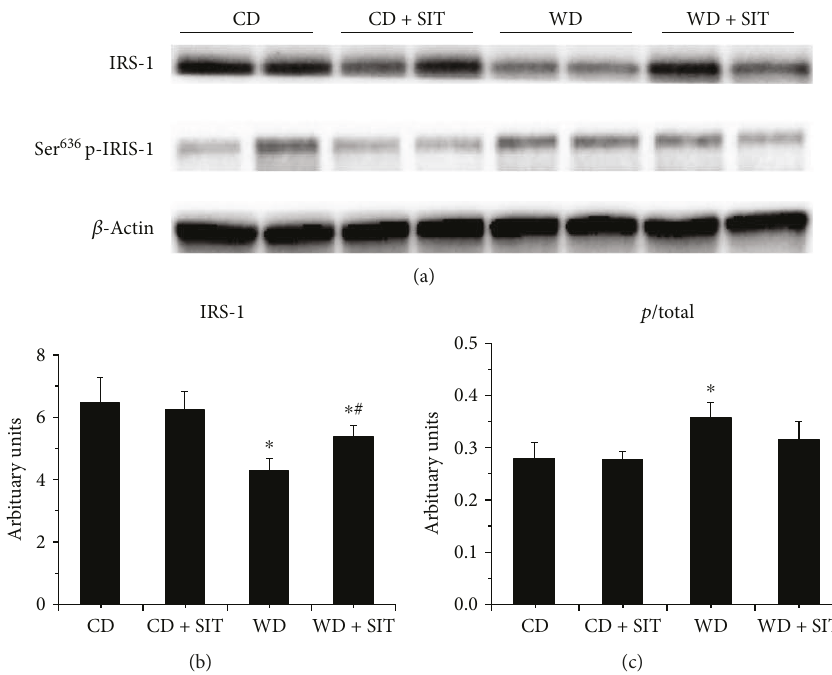
Figure 4: Western blot analysis of phosphorylated ( p ) and total IRS-1 in pancreas tissue at the end of experiment, total IRS-1 decreased, and Ser phosphorylation of IRS-1 increased in WD mice. SIT treatment reduced the total IRS-1 signi fi cantly, not the ratio of p /total. ∗ P < 0 05 compared to the CD group; # P < 0 05 compared to the WD group.